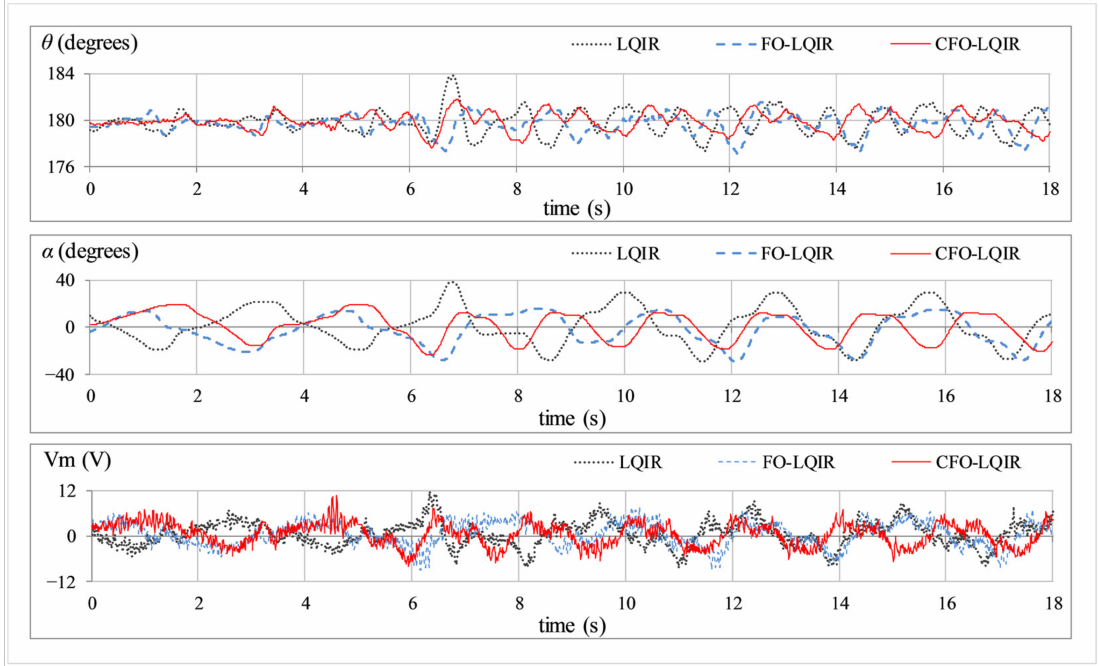
Figure 8. SRIP’s response under model